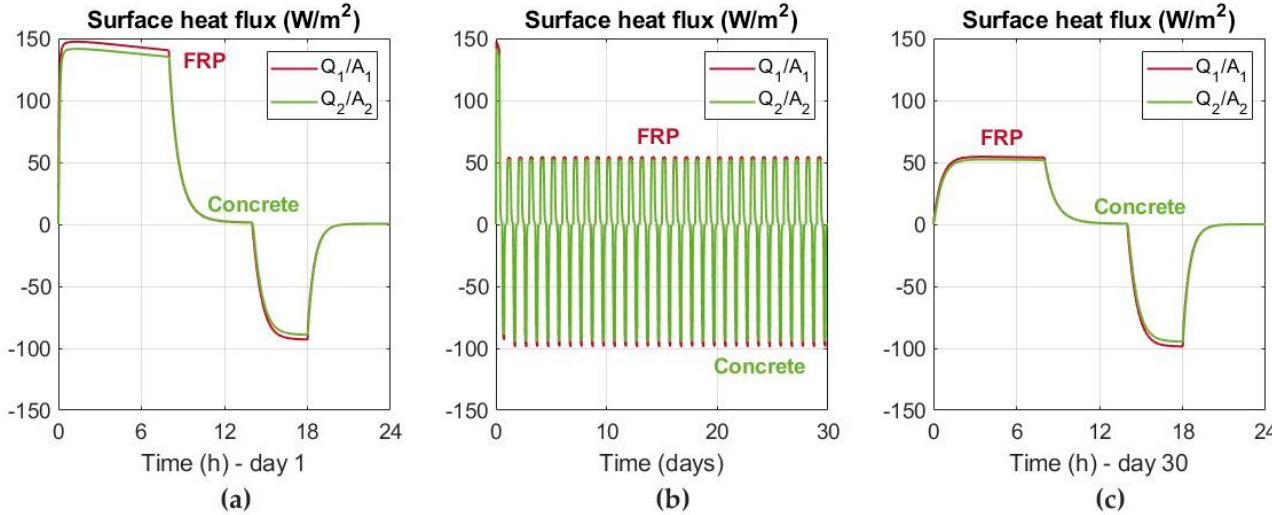
Figure 6. Surface heat flux of FRP and concrete lining for 30 charging and discharging cycles considering FRP as sealing layer. ( a ) First day; ( b ) 30 days of operation; ( c ) 30th cycle.